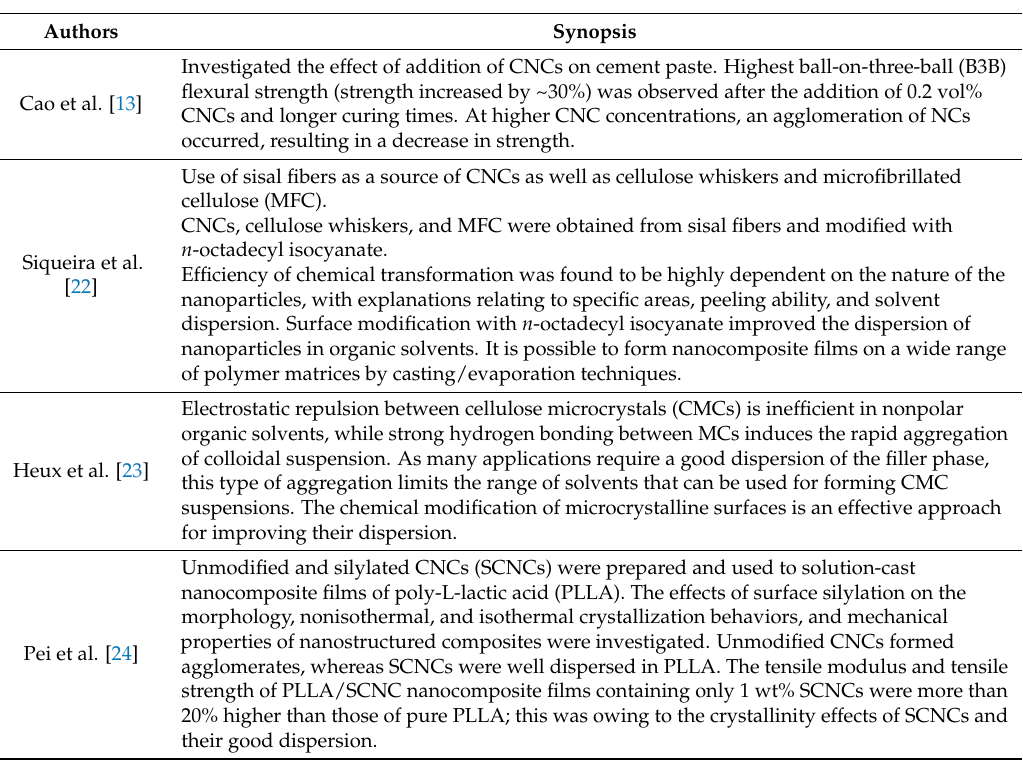
Table 1. Review of existing literature on cellulose nanocrystals